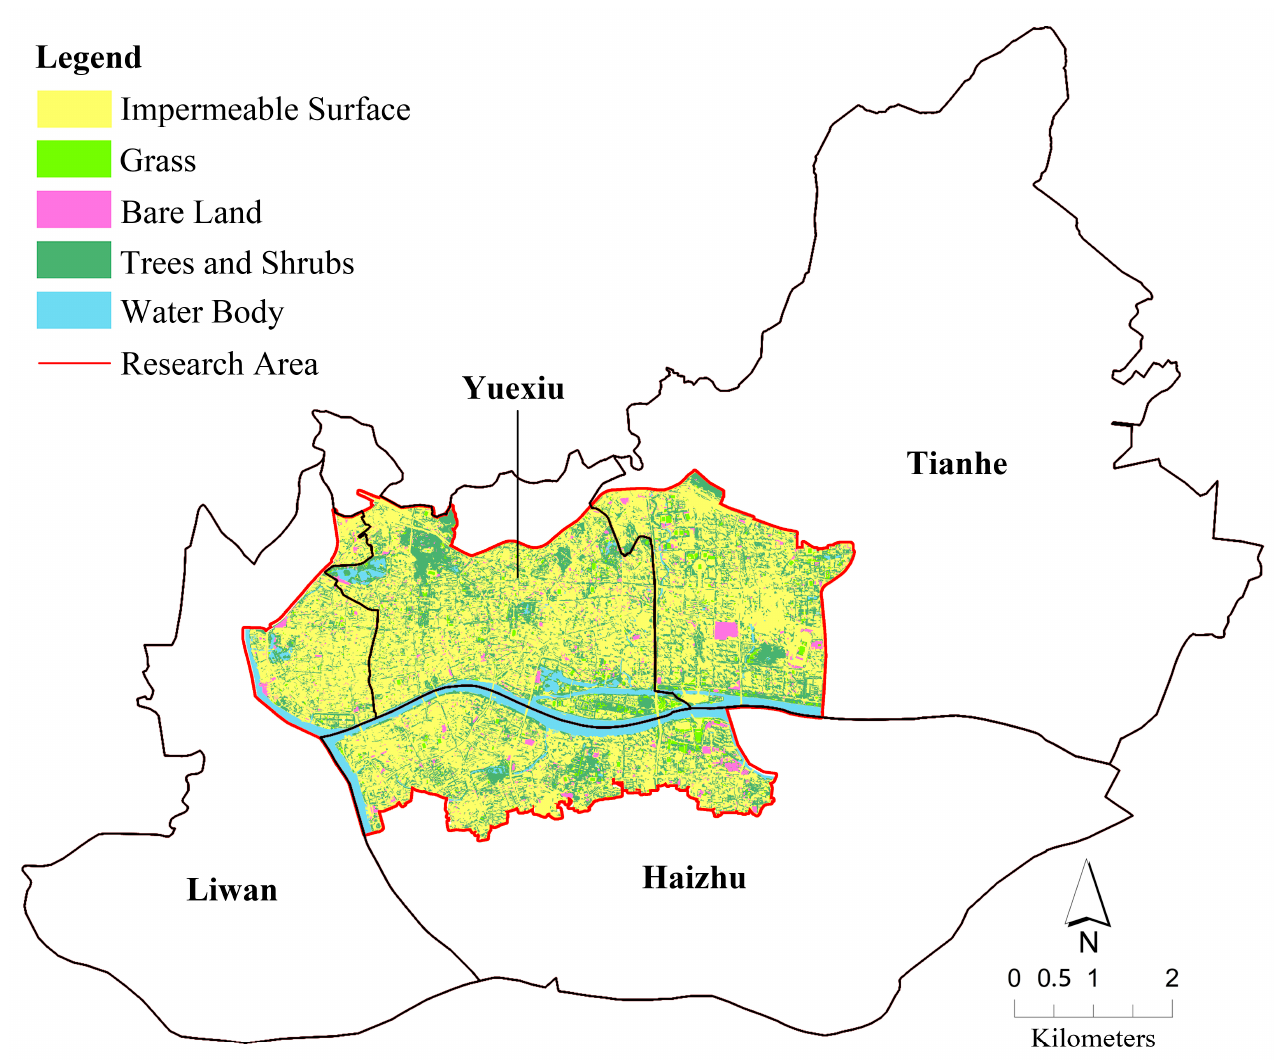
Figure 3. Land use coverage map of the main urban area of Guangzhou. Table 4. Statistical table of land use coverage in the main urban area of Guangzhou.